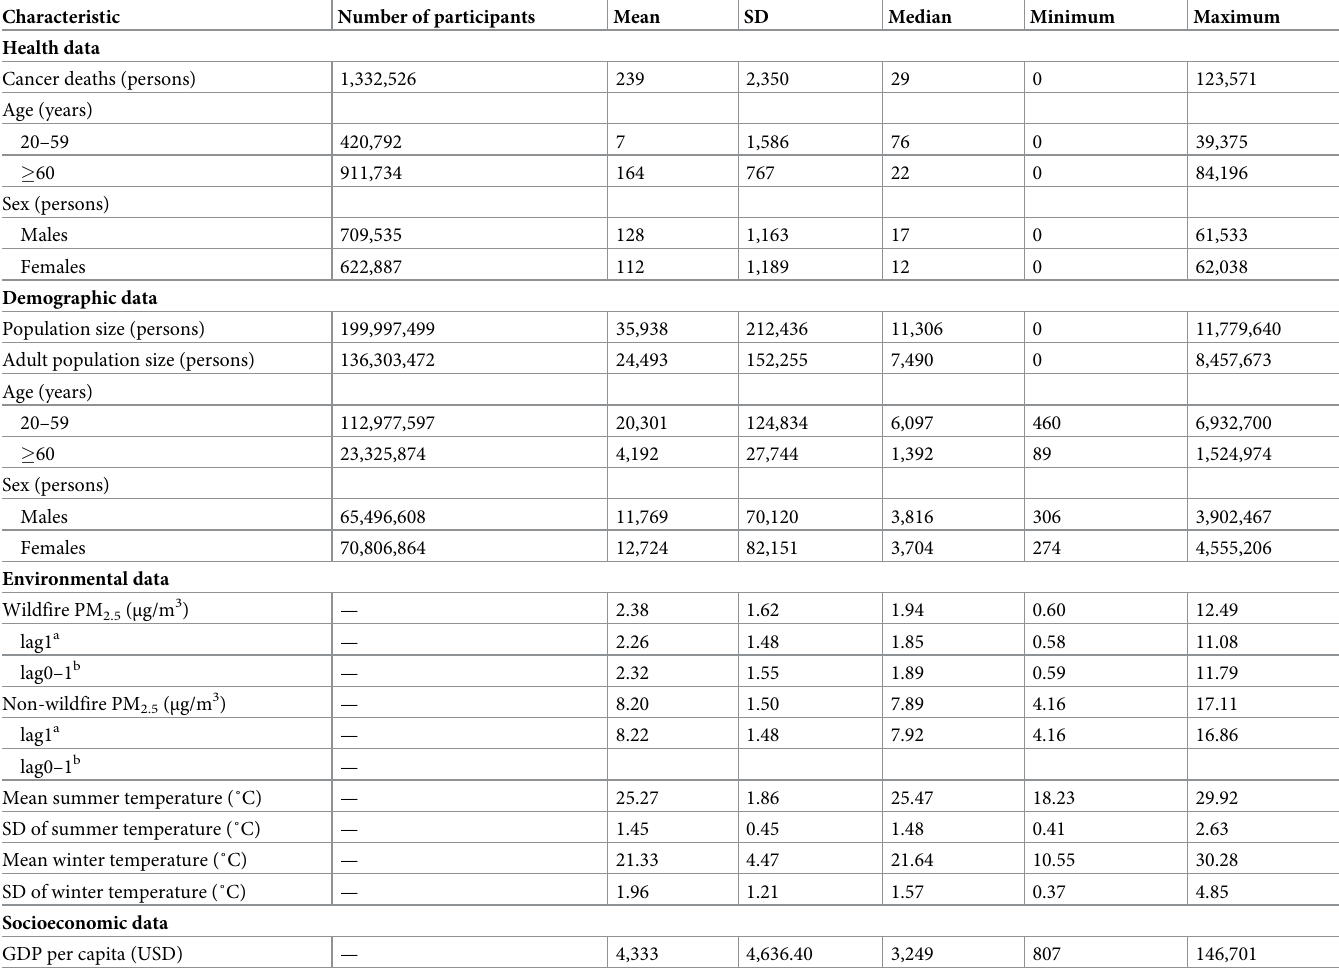
Table 1. Descriptive characteristics of study participants and summary statistics for the 5,565 municipalities in Brazil.